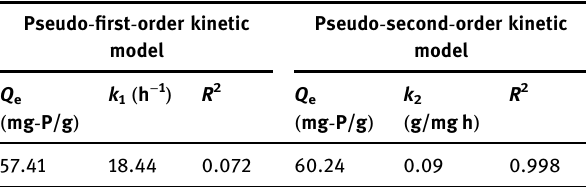
Table 4: The kinetic fi tting parameters of phosphorus adsorption on synthetic zeolite Pseudo - fi rst - order kinetic